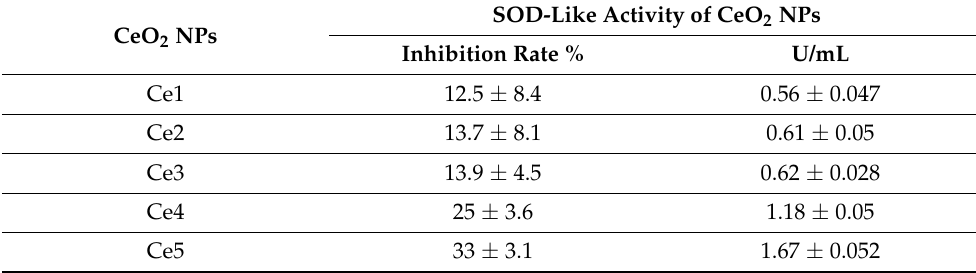
Figure 4. The AFM images of insulin amyloid fibrils formed alone (control) and in the presence of different concentrations of Ce2 (inhibition of amyloid aggregation). White scale bars represent 2 μ m. Table 2. The SOD-like activity of CeO 2 NPs monitored using an SOD